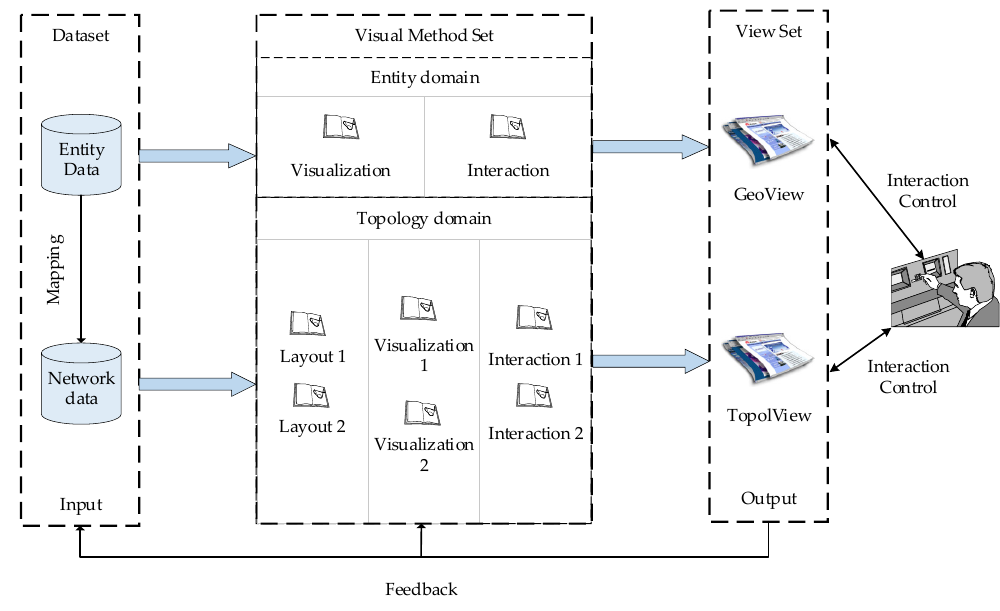
Figure 5. SINDVis Figure 5. SINDVis architecture.